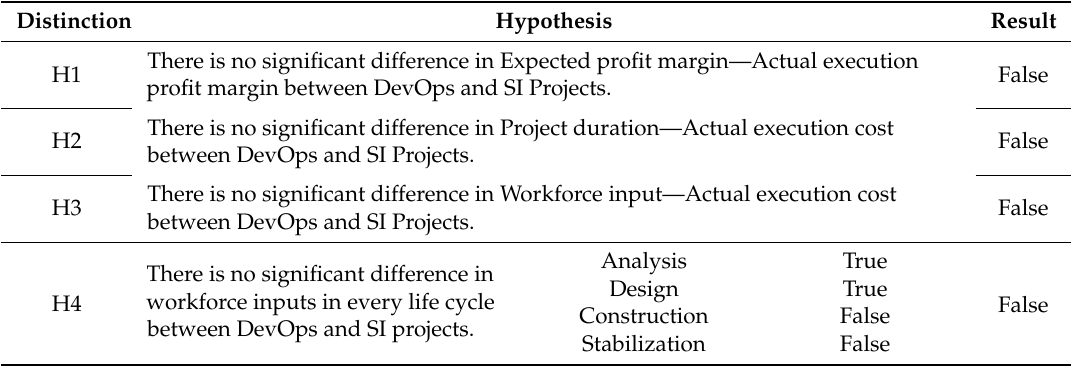
Table 16. Verification/Estimation results of hypotheses.